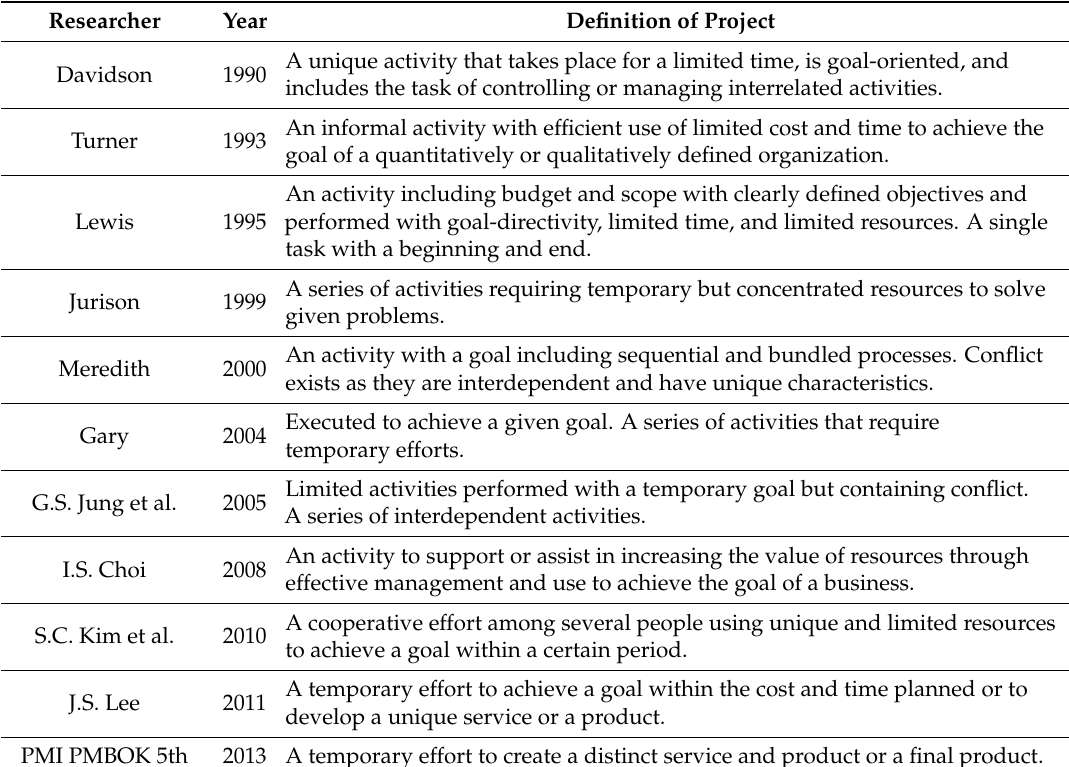
Table 2. The Definitions of